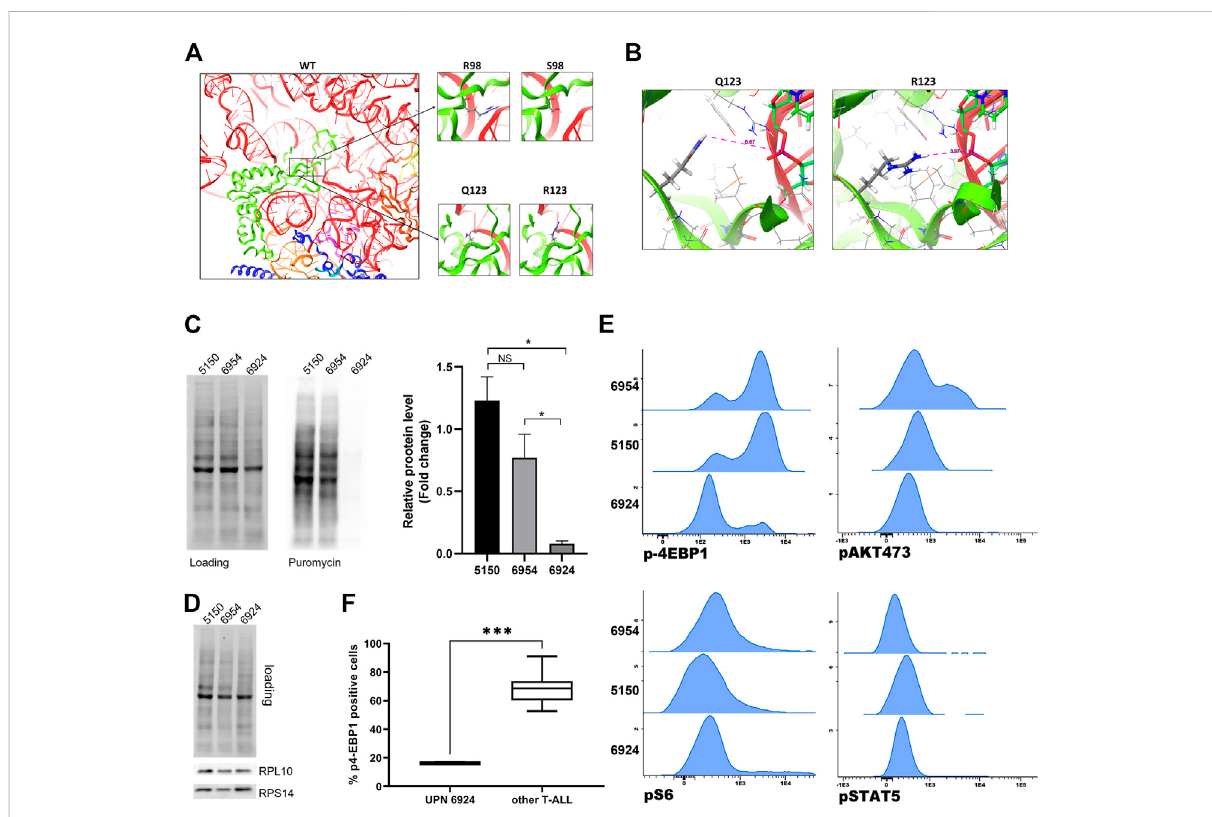
FIGURE 4 Modelling and functional study of RPL10 Q123R. (A) Representation of human RPL10 structure (in green) inside the ribosome, in proximity with RNA molecules (in red and light orange) and other chains such as RPL5 (in blue), RPL13 (in purple) and RPL36A (in dark orange). The black boxes representthepositionoftheresiduesR98andQ123.The fi gureshowthattheseresiduesareclosetotheribosomalcatalyticcenter.Ontheright,the amino acids substitutions R98S and Q123R are represented. WT: wild type; R: arginine; Q: glutamine; S: serine. (B) Predicted structure of the RPL10 Q123R mutation in relation to bystander ribosome components. The distances are measured from the side chain of the R to the 28S rRNA U1866. The model is based on PDB structure 6EK0. (C) Western blotting of SUnSET assay. On the left, representative experiment. SDS-PAGE separation was achieved on a 10% acrylamide gel. On the right, average of densitometric analyses of two independent experiments reported as fold change over an average of control samples (5150 and 6954, from patients with WT RPL10); 6924 is the sample from the patient bearing the RPL10 Q123R mutation. N = 2 experiments, * p < 0.05 by unpaired t test. NS: not signi fi cant. (D) Representative western blot of RPL10, RPS14 in the same patients. (E) Basal expression of p4EBP1, pAKT, pS6 and pSTAT5 was measured by phospho fl ow in three T-ALL samples; histograms represent MFI of each phosphoprotein and indicate a signi fi cant downregulation of p4EBP1 in patient 6924, Q123R RPL10 mutated, compared to the control patients (5150 and 6954). No statistically signi fi cant differences in pS6, pAKT 473 and pSTAT5 expression were found. (F) Box plot distribution of